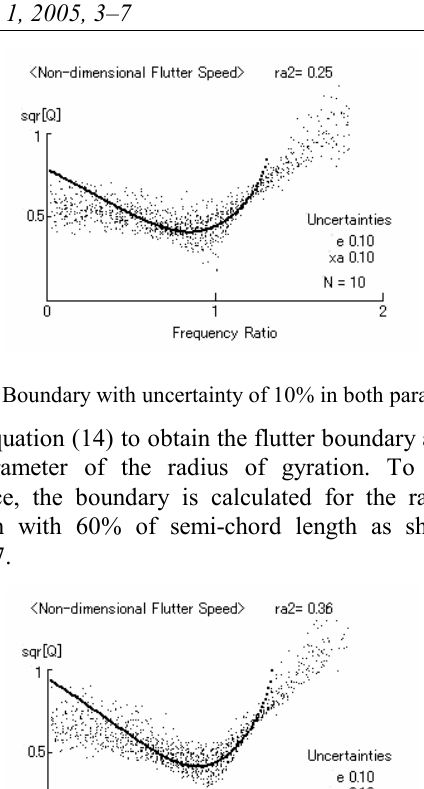
Fig 4. Boundary with uncertainty in the location of the elastic axis